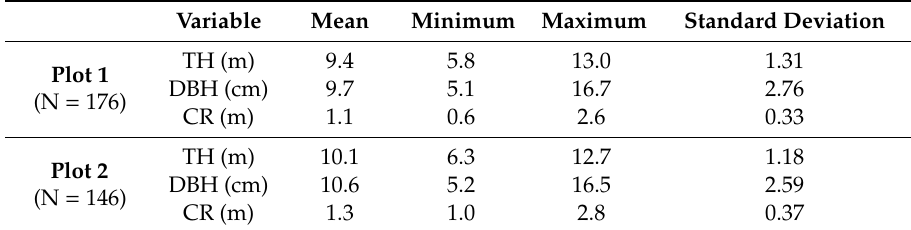
Table 1. Summary statistics of Larix olgensis trees measured in the